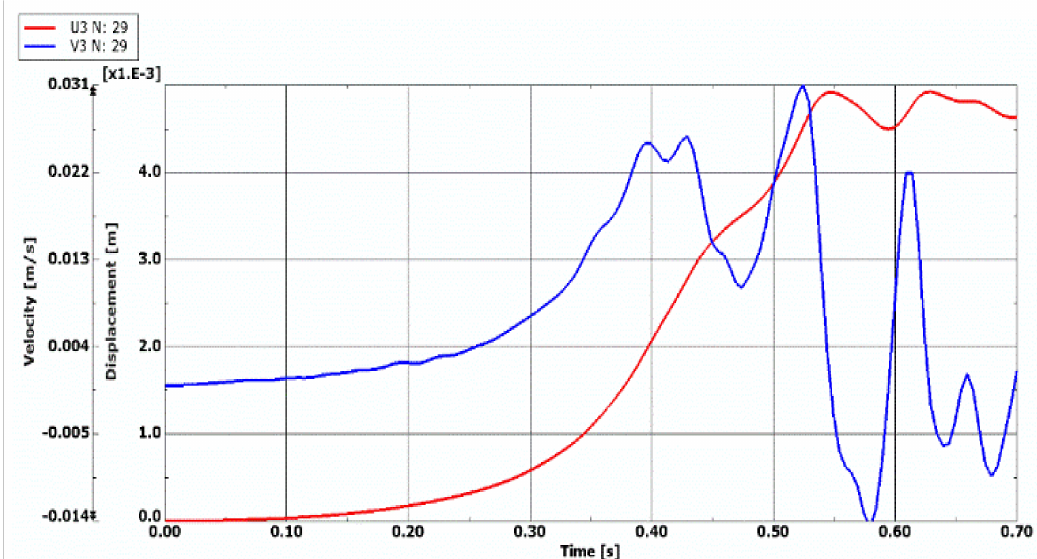
Figure 9. Time histories of deflection and velocity of deflection of undamaged FEM plate